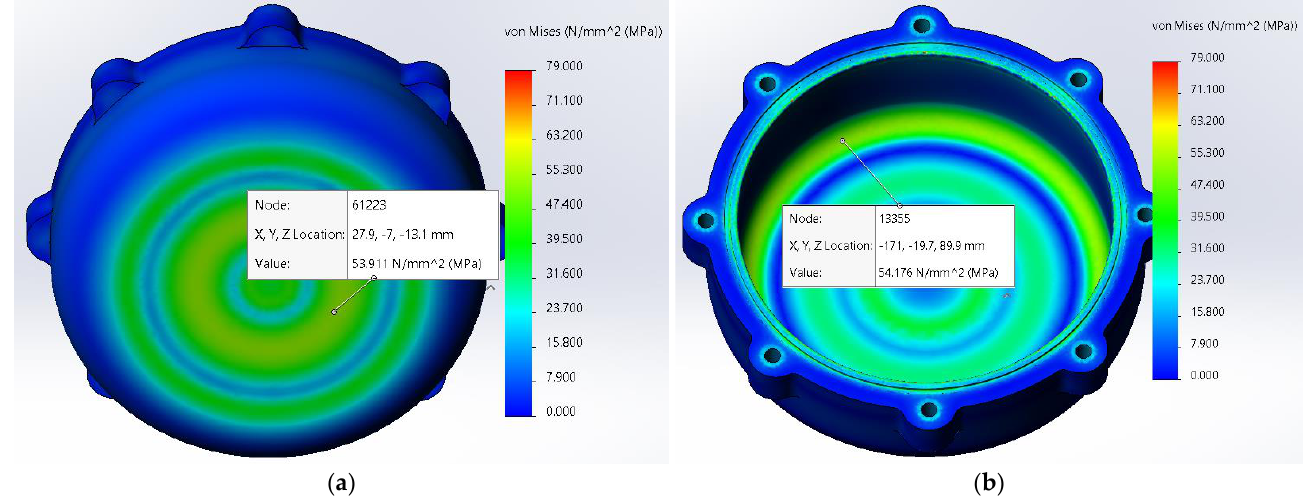
Figure 12. Von Mises equivalent stresses for the box structural validation: 24 V ( a ) and 48 V assem- blies ( b ).